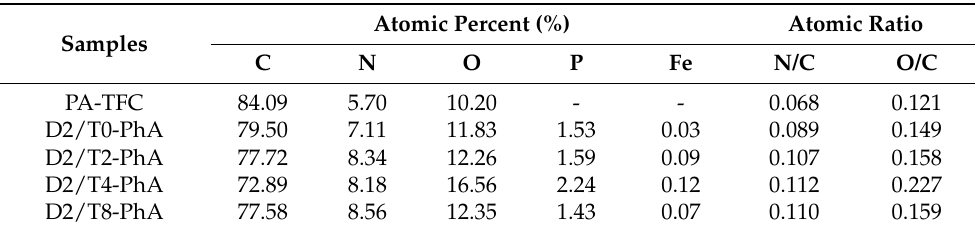
Table 1. The relative surface atomic concentration of the PA-TFC membrane and the DA/TA-PhA modified membranes tested by EDS spectra.